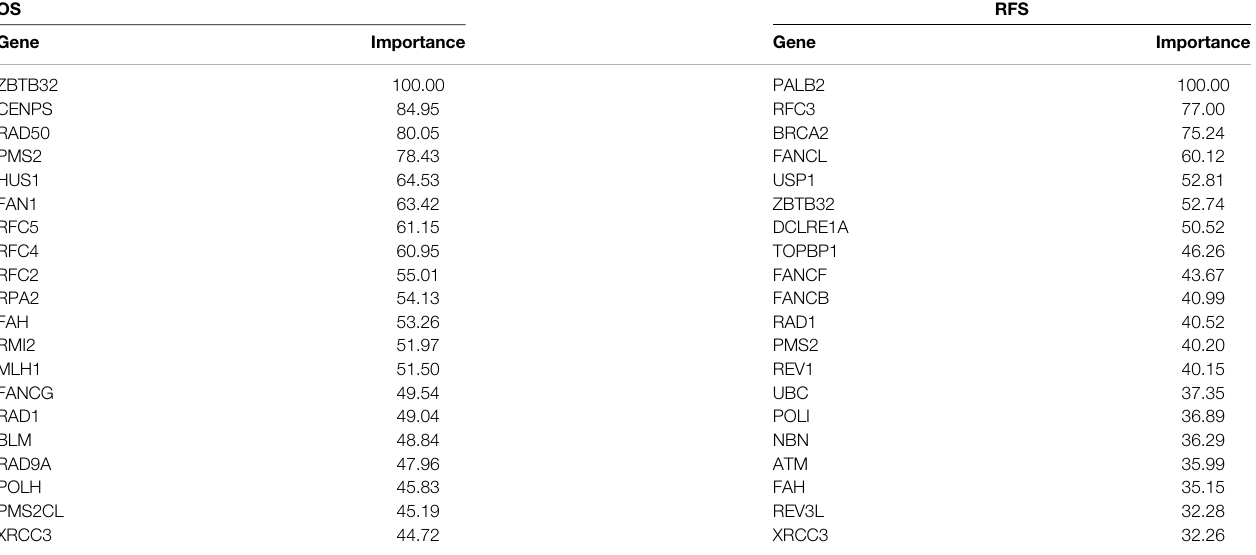
TABLE 6 | ROC curve variable importance of SVM model for CC prognosis prediction. OS RFS Gene Importance Gene